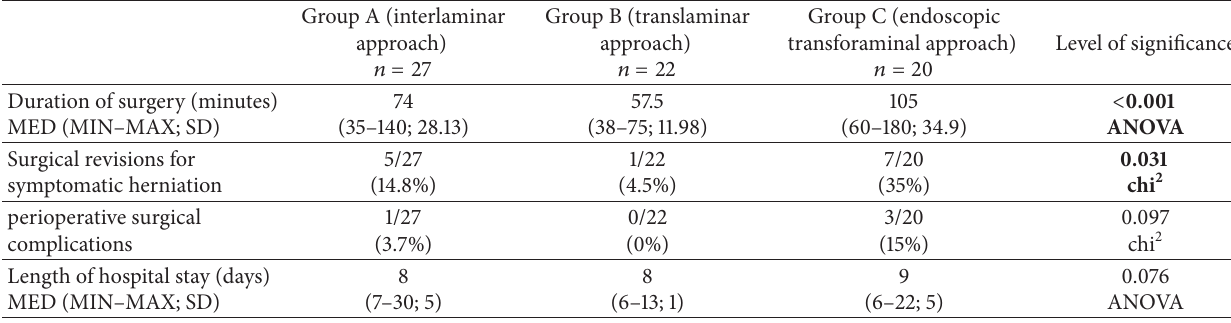
Table 2: Surgical